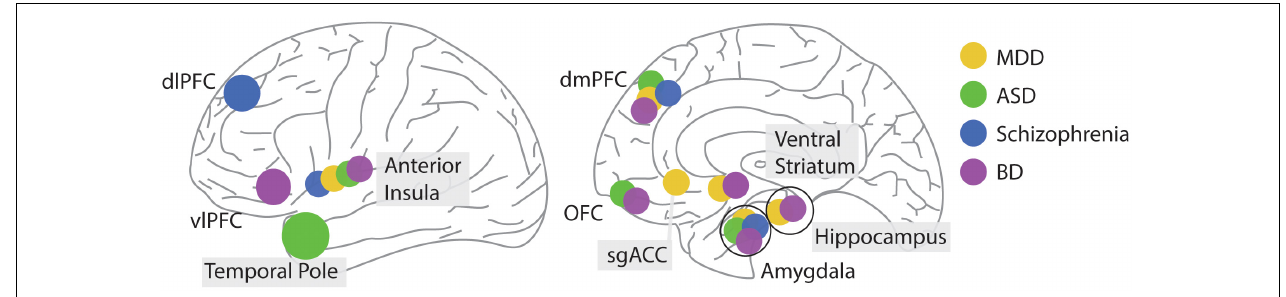
FIGURE 5 | Location of differential brain activity during social decision making associated with different psychiatric conditions. Brain regions are illustrated on a lateral (left) or sagittal (right) view of the human brain.